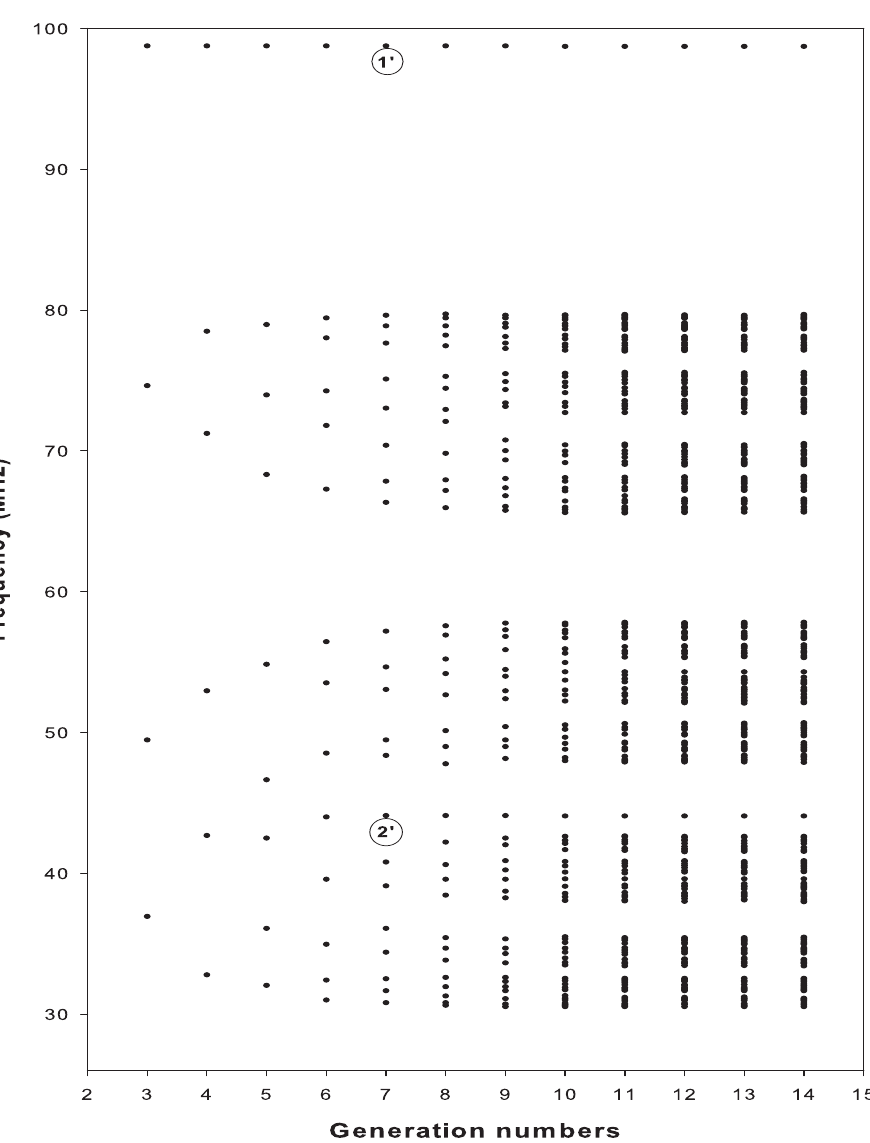
Figure 10. Same as in Figure 7 but for a FS with vanishing magnetic field on the top surface of the structure and vanishing electric field on the bottom surface. Here, the discrete modes are obtained from the minima of the transmission spectra displayed in Figure 6. The labels 1 (cid:48) and 2 (cid:48) correspond to the surface